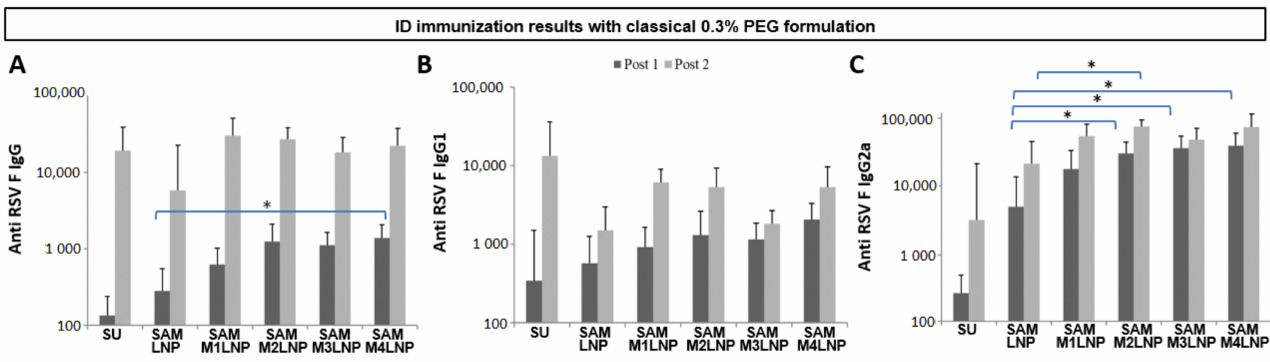
Figure 5. Immunization titers of RSV F SAM antigen formulated with classical 0.3% PEG LNP and MLNP formulations and administered through ID route. Median IgG ( A ), IgG1 ( B ), and IgG2a ( C ) titers, considering non adjuvanted subunit (SU) group as control. * p < 0.05 ( n =